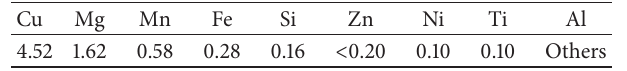
Table 1: Chemical composition of 2A12 aluminum alloy (mass fraction, %).